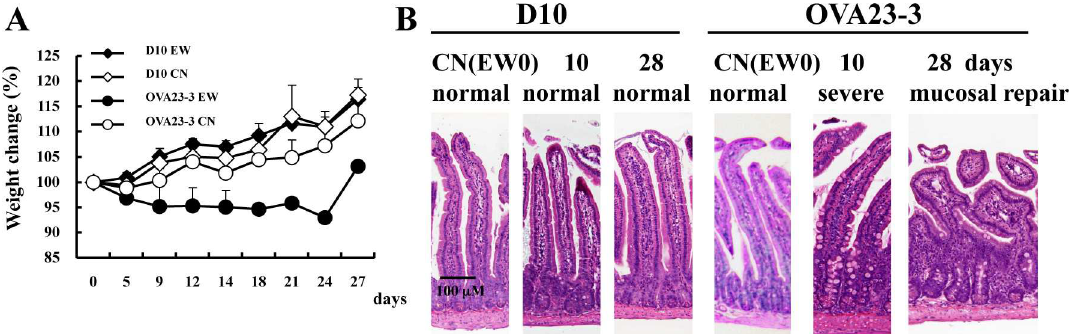
Fig 1. Lack of weight loss and enteropathy in EW-fed D10 mice. A , Weight change (relative to day 0 [100%]). The loss was solely indicatedin EW-fed OVA23-3 group. B , H&E-stained histology of the jejunumof mice fed with control diet (CN) or fed with EW diet (EW) for 10 or 28 days. Severe inflammation (crypt elongation,villousatrophy, thickness of muscular layer, goblet cell hyperplasia) was present in day 10 of EW-fed OVA23-3 mice but not in that of EW-fed D10 mice (10 days). Furthermore, EW-feedingof OVA23-3 mice for 28 days (28 days) shows severe villous blunting, indicatingmoderate degree of inflammation under mucosal repair. These results are representativeof three independentexperiments using CN-fed D10 mice (n = 4), EW-fed D10 mice (n = 4) CN-fed OVA23-3 mice (n = 2), and EW-fed OVA23-3 mice (n =